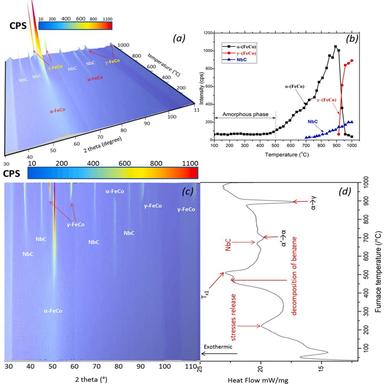
The thermal evolution of the X-ray diffraction pattern recorded in situ up to 1000 °C upon annealing an amorphous Fe38.5Co38.5Nb7B15Cu1 sample as obtained by 40 h of wet milling. (λ = 1.79026 Å). The thermal stability and phases evolution upon heating can be seen by correlation of the in-situ X-ray diffraction patterns at high temperatures (HT-XRD) (a - isometric view, b - development of most intense peaks of the α-(Fe, Co), NbC and γ-(Fe, Co) phases versus temperature, c - top view) with the differential s